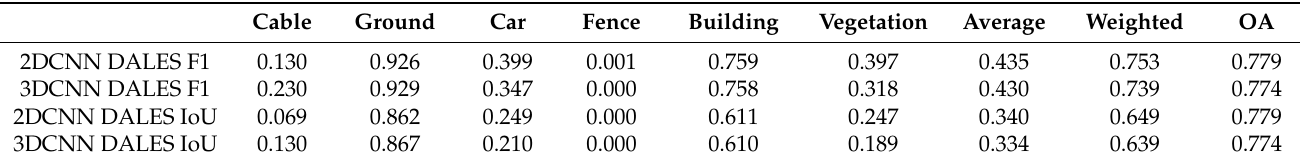
Table 15. Averaged and weighted F1 and IoU scores for 2DCNN and 3DCNN classifiers trained on DALES dataset and predicting on ISPRS Vaihingen dataset. The OA is also reported.